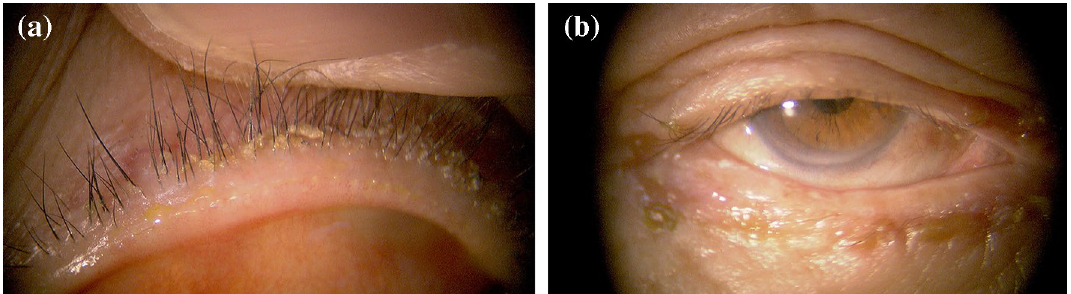
Figure 2. Representative slit-lamp photographs of anterior blepharitis after cataract surgery. Slit-lamp photograph of left upper eyelid margin of 70-year-old female with staphylococcal blepharitis 2 months after cataract surgery. Severe collarettes formation at the base of the cilia are noted ( a ). Slit-lamp photograph of right eye of 80-year-old male with seborrheic blepharitis 2 months after cataract surgery. Severe greasy scaling is noted in the lower eyelid ( b